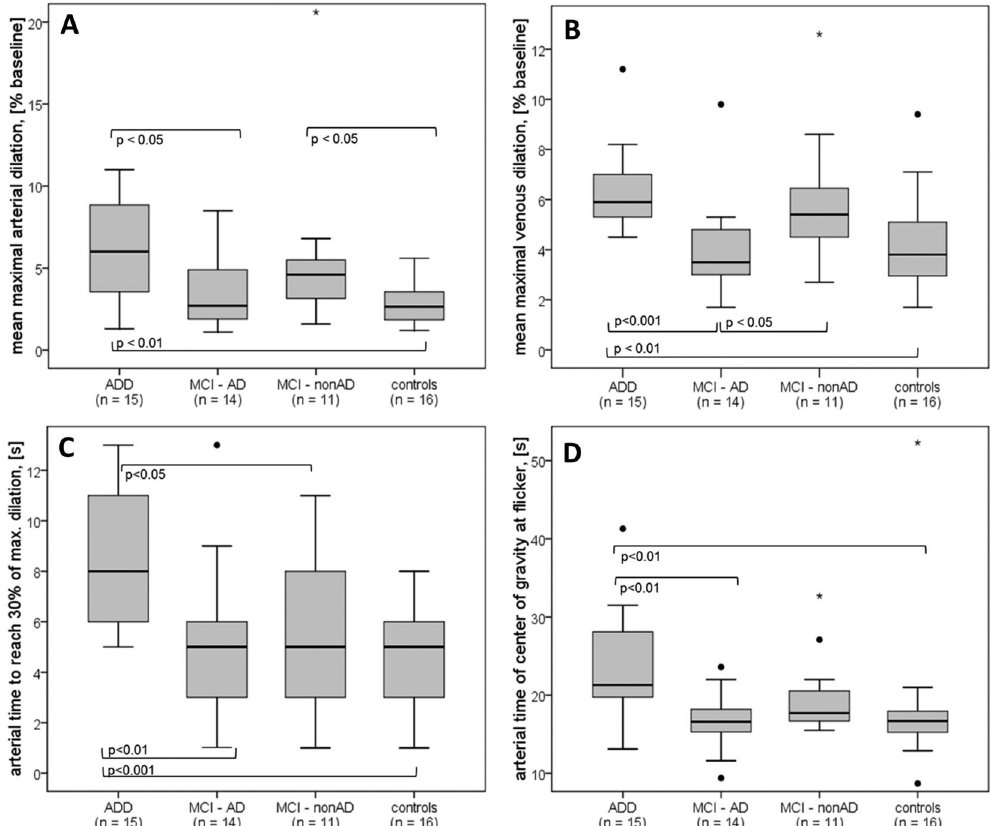
Figure 4. Maximal arterial and venous dilation ( A , B ) and latency parameters ( C , D ) in groups with MCI group divided in two subgroups: hypotheses testing with Mann-Whitney-U-Test. Exact p-values reported without correction for multiple comparisons. • , * Suspected and qualified outliers respectively. Note an increased and delayed retinal vessel response in